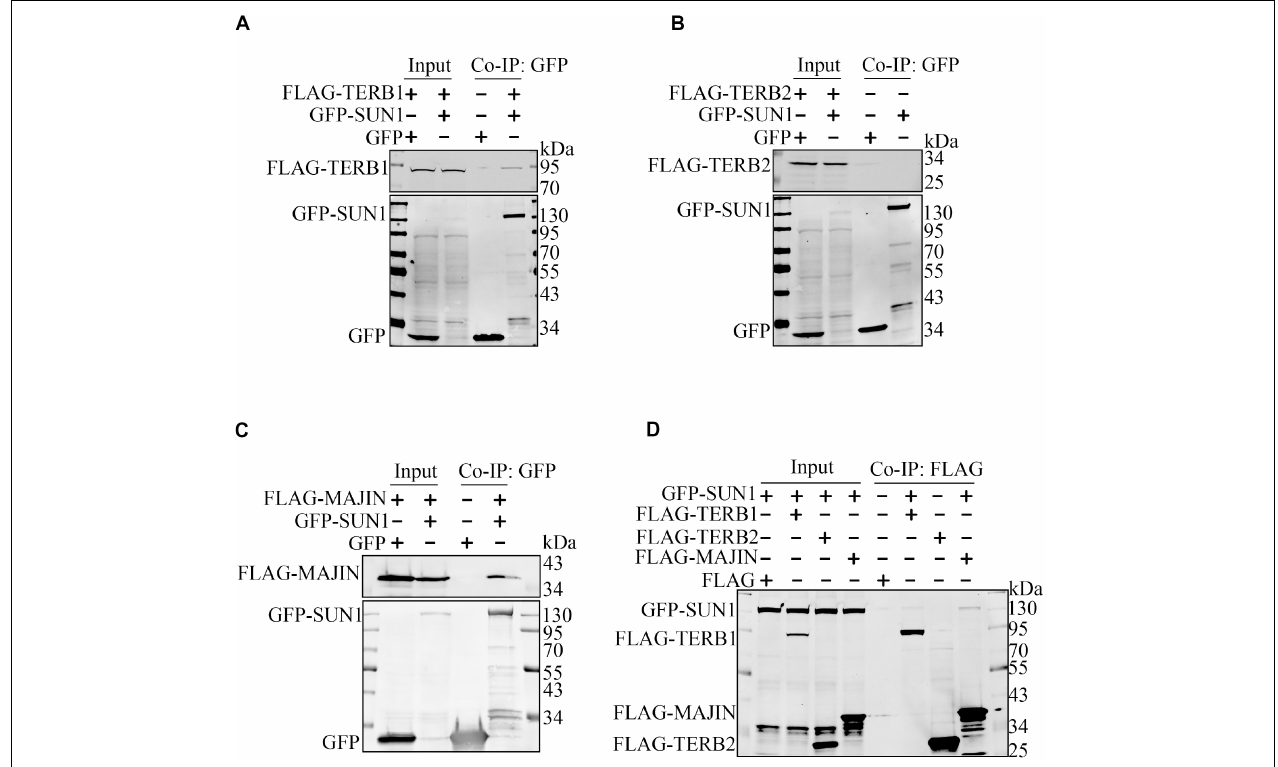
FIGURE 1 | SUN1 is associated with MAJIN. The indicated expression plasmids were transfected into HEK293T cells, and immunoprecipitation was performed to analyze the interactions of SUN1 with TERB1 (A) , TERB2 (B) , and MAJIN (C) by GFP-Trap or Anti-FLAG M2 Affinity Gel (D) .